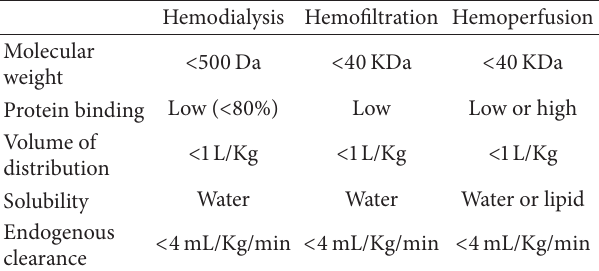
Table 1: Optimal physicochemical properties for extracorporeal removal of